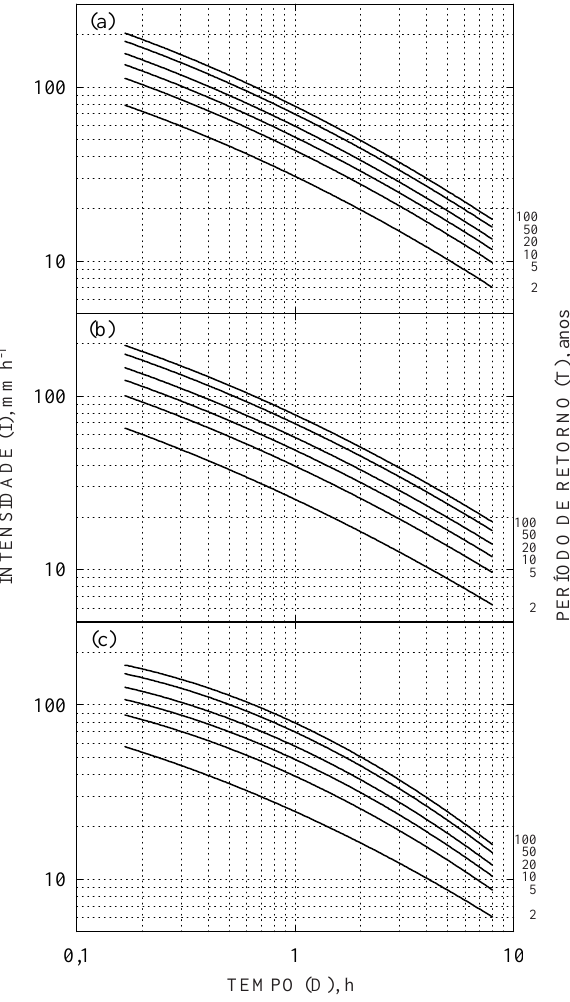
Figura 1. Períodos de retorno do padrão de chuvas avançado (a), intermediário (b) e atrasado (c) em Santa Maria (RS), considerando a intensidade e duração das